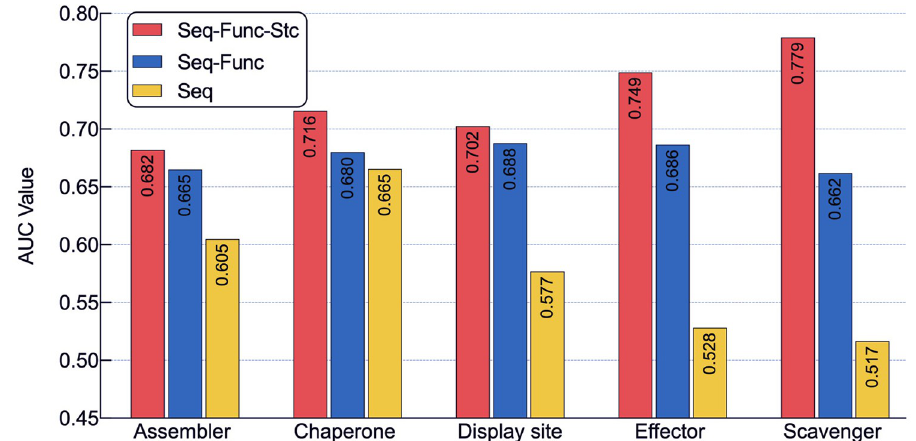
Fig 4. The predictive results of PCLM model in DMFpred with different language models. Seq represents the PCLM with only sequence language model, Seq-Func denotes the PCLM with the combination of sequence language model and function language model, and Seq-Func-Stc stands for the PCLM model, which is the combination of sequence language model, function language model and structure language model. The AUC values were calculated on the validation data